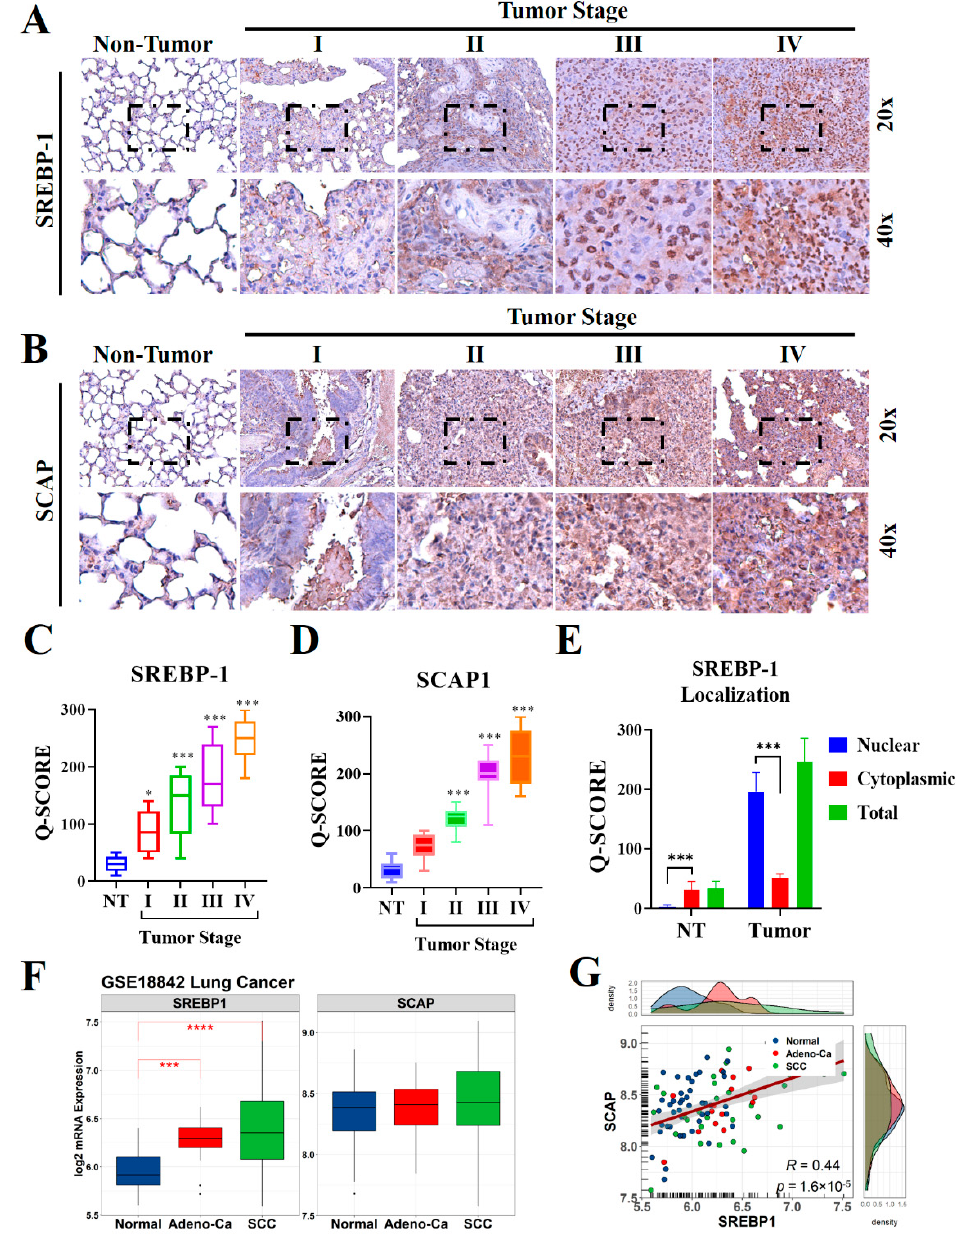
Figure 1. SCAP and SREBP-1 expression in NSCLC and normal lung tissues. Representative IHC images used to measure the differential expression of ( A ) SREBP-1and ( B ) SCAP in NSCLC tissues from patients with stage I, II, III, and IV disease and in non-tumor lung tissue sam- ples. ( C – E ) Quantification of SREBP-1 and SCAP expression in non-tumor and tumor lung tis- sue of different stages, with in-depth analysis of SREBP-1 nuclear localization in lung tissue. ( F , G ) Expression and correlation of SREBP-1 and SCAP at the mRNA level in NSCLC samples from the GSE18842 lung cancer microarray dataset compared to the normal lung samples. * p < 0.05, *** p < 0.001, and **** p <